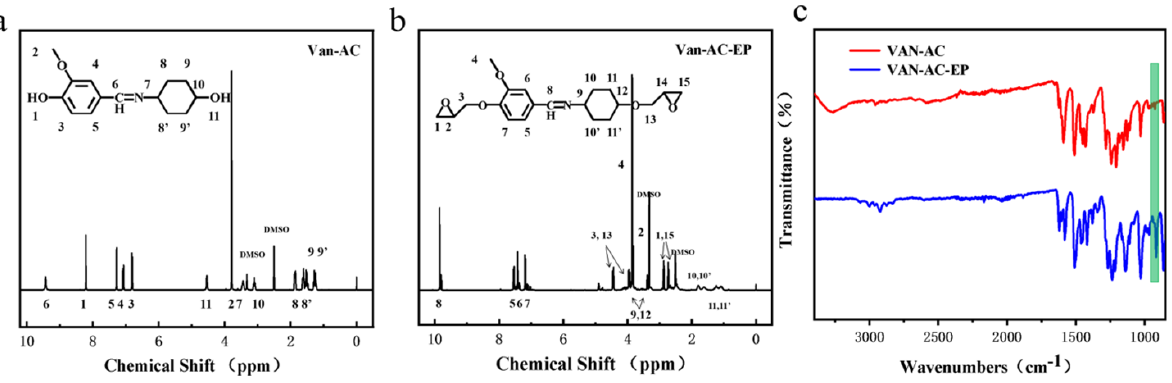
Figure 1. 1 H NMR spectra of VAN-AC ( a ) and VAN-AC-EP ( b ); FT-IR spectra of VAN-AC and VAN-AC-EP ( c ).